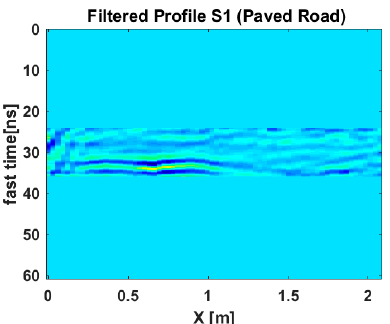
Figure 13. Portion of the radargram related to the paved road.